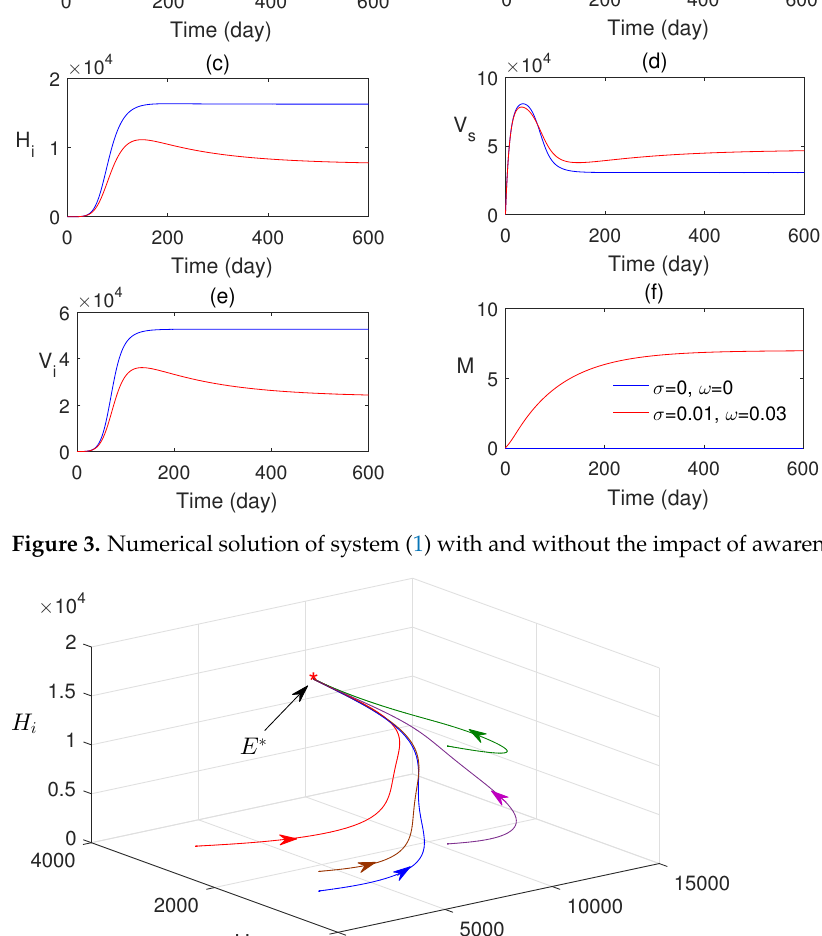
H a H i phase space. Parameter values are the same as in − −